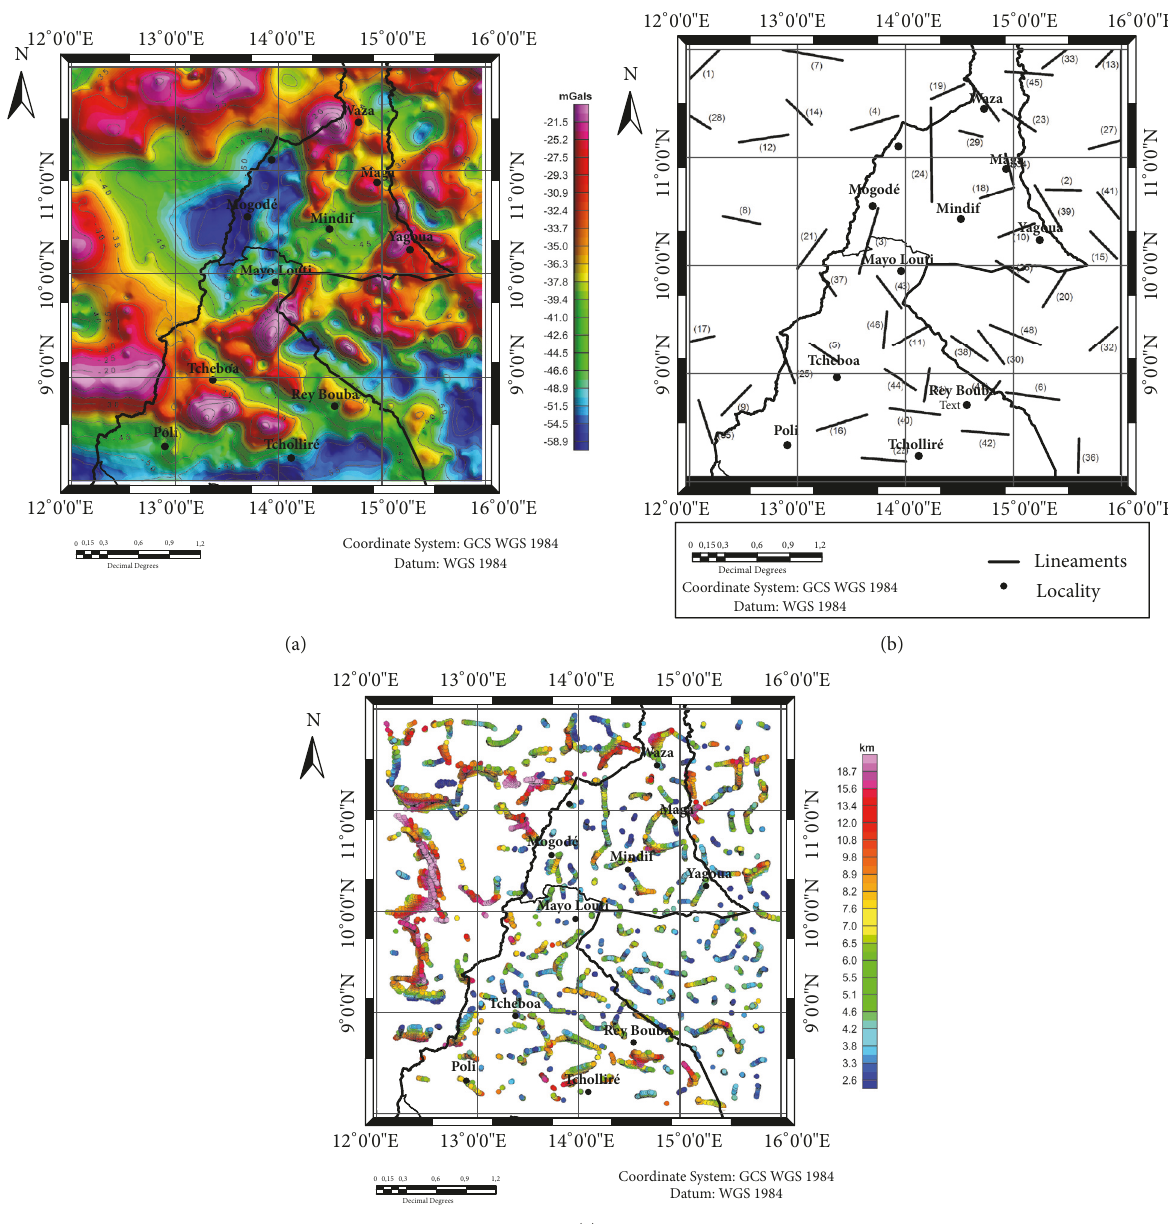
Figure 16: Bouguer (a), lineaments (b), and Euler (c) maps obtained for three